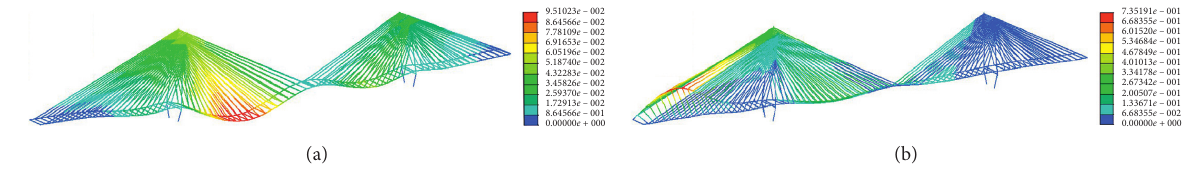
Figure 9: Displacement responses for (a) intact case and (b) damaged case (unit: